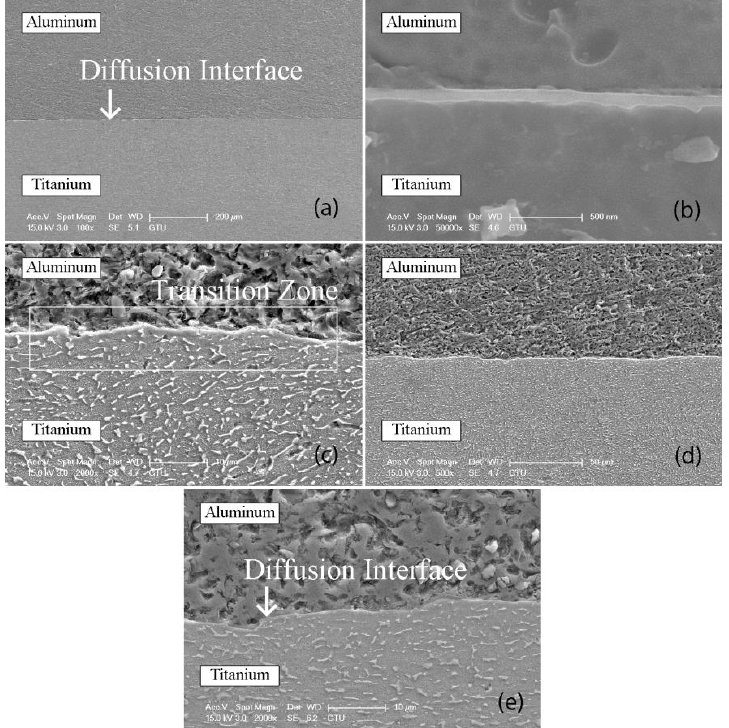
Figure 8. SEM images of different parameters: ( a ) 560 °C for 45 min; ( b ) 600 °C for 45 min; ( c , d ) 600 °C for 60 min; ( e ) 640 °C for 30 min.